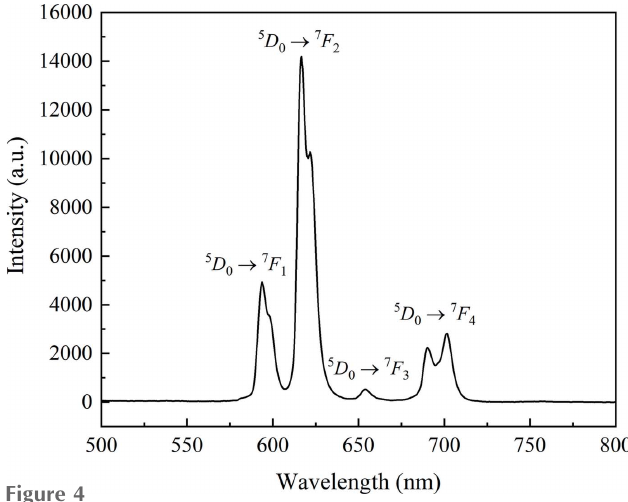
Figure 4 Room-temperature photoluminescent emission spectrum of the title